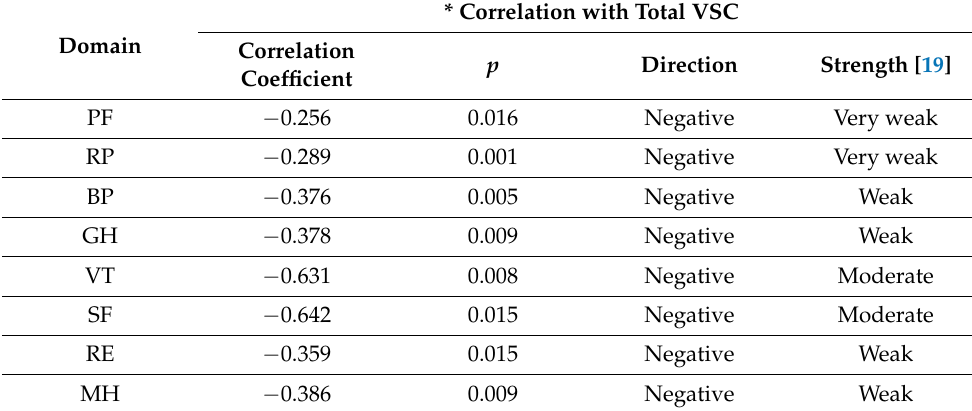
Table 6. SF-36 domains’ and total VSC